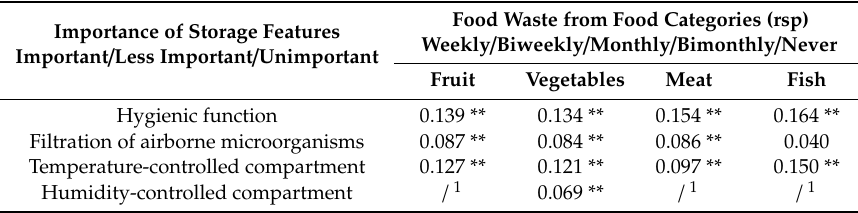
Table 5. Correlations between the importance of food category-related storage features and the rate of food waste (** = significance r sp at 0.01).